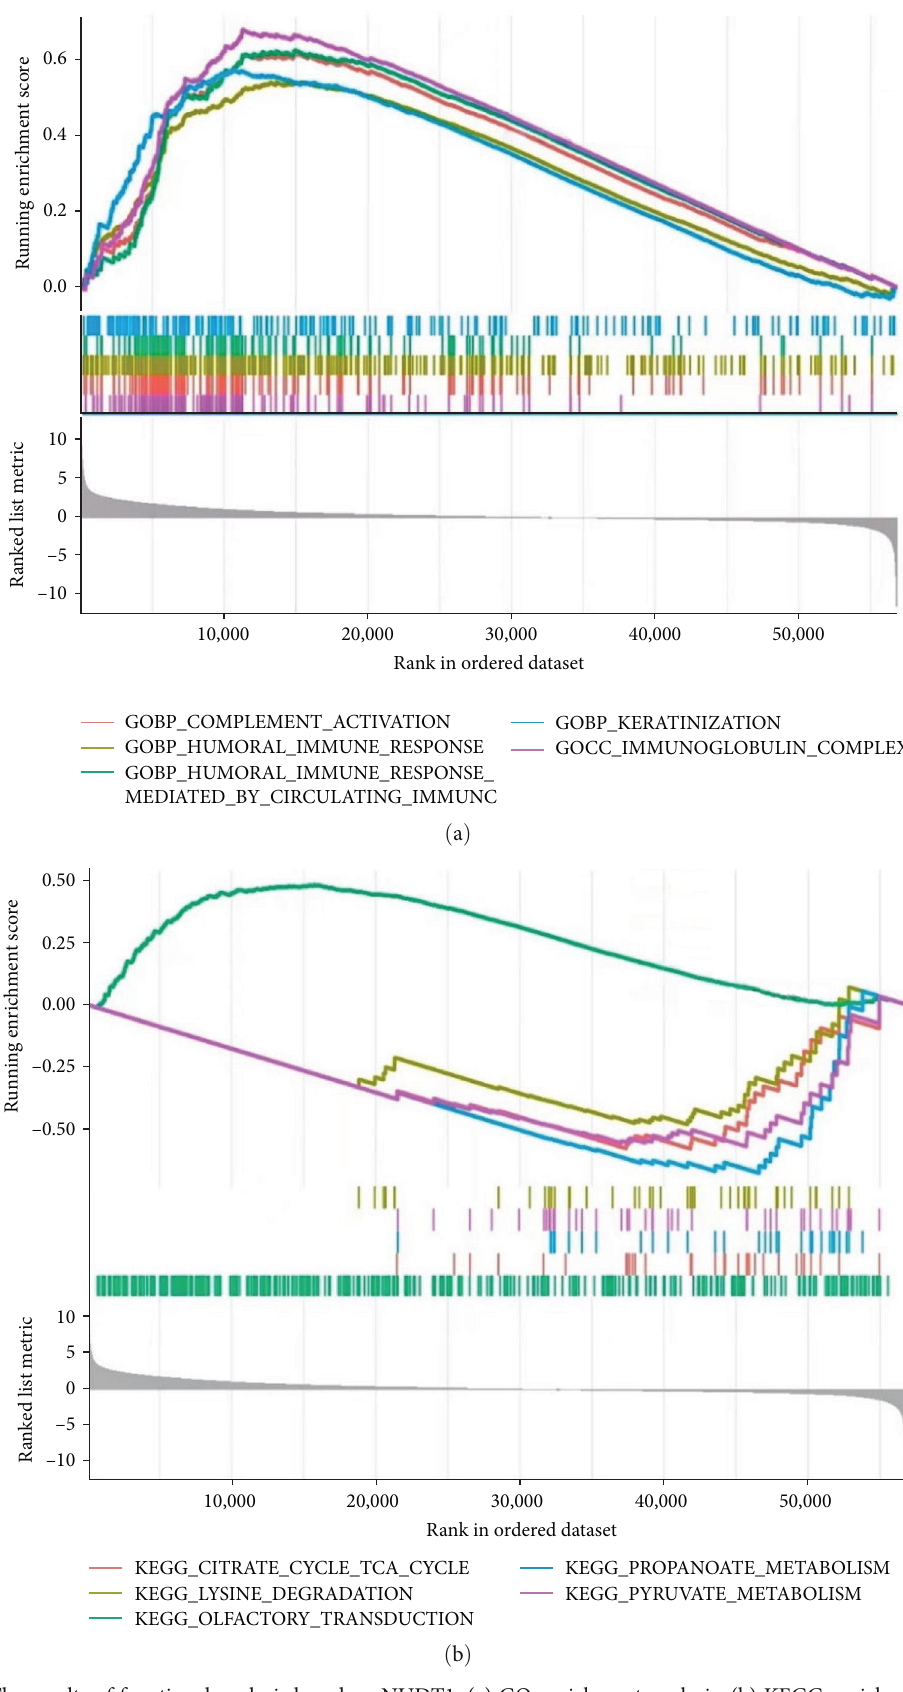
F IGURE 9: The results of functional analysis based on NUDT1: (a) GO enrichment analysis; (b) KEGG enrichment